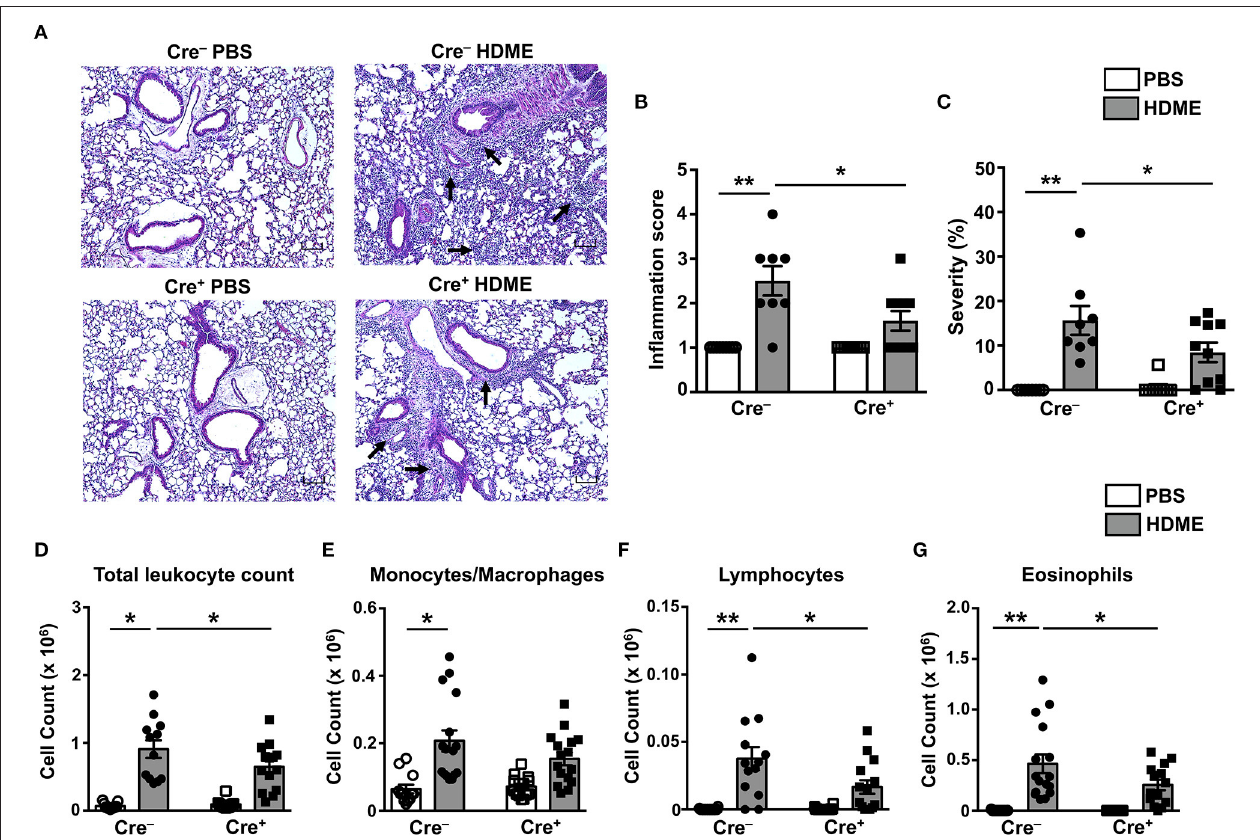
FIGURE 5 | Reduced airway inflammation and immune cell infiltration in mice lacking GRK2 in T cells. (A) Hematoxylin and eosin (H&E) staining of lung section of Cre − and Cre + mice injected with PBS or HDME. Scale bar = 100 µ m. Representative images of the lungs at 4 × magnification is shown. Black arrows indicate cellular infiltration (inflammation) around the bronchioles and blood vessels. (B) Bronchial inflammation and (C) severity scores in PBS and HDME-treated Cre − and Cre + mice are shown. (D–G) BALF from Cre − and Cre + mice injected with PBS or challenged with HDME were analyzed for (D) total leukocyte counts and differential cell counts of (E) monocytes/macrophages, (F) lymphocytes and (G) eosinophils. Data are presented as mean ± SEM and are pooled from three independent experiments with a total of n = 5–7 for PBS and n = 13–16 mice for HDME-treated groups. Both male and female mice were used for this experiment Statistical significance was determined by Student’s unpaired t -test. * p ≤ 0.05, ** p ≤